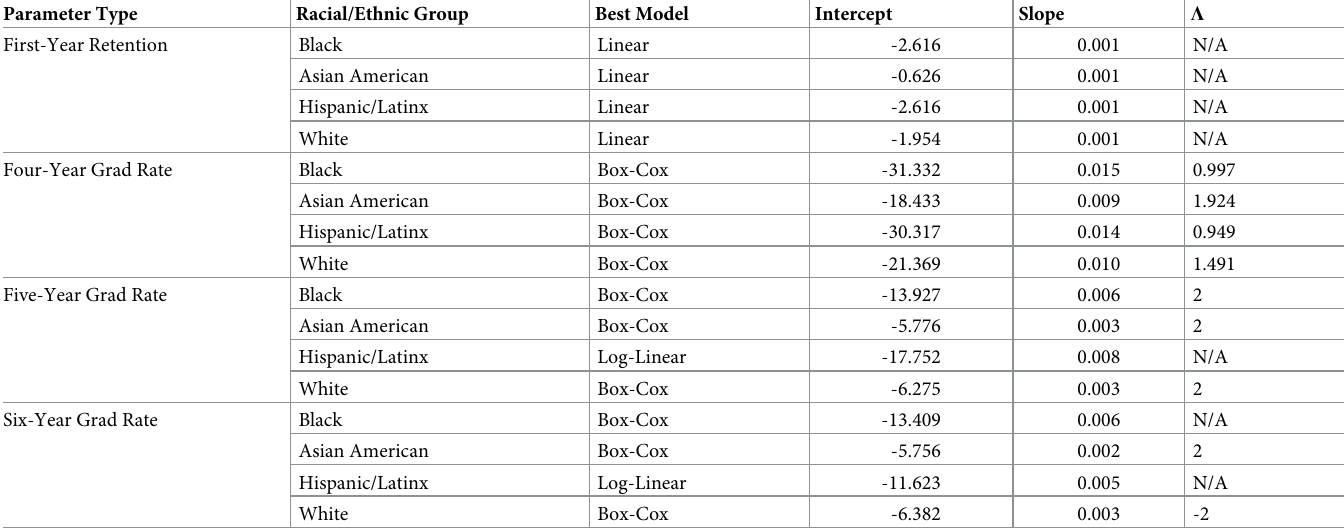
Table 2. Regression models for retention and graduation rates at University of California-Berkeley. Our Markov chain model (see Fig 1) requires specification of the parameters λ 4 G , λ 5 G , λ 6 G , and ρ , which are related, respectively, to the four-year graduation, five-year graduation, six-year graduation, and first-year retention rates. These rates must be specified for each year and for each racial/ethnic group. We assess the fit of linear, log-linear, and optimal Box-Cox models on historical data. We choose the preferred model, specified in the table above, and use it to forecast future values. Fig 3 shows various models for four-year graduation rates, corresponding to the top sec- tion of the table above. The column labeled Λ is an exponent used in the Box-Cox transformation, and thus is relevant only to those